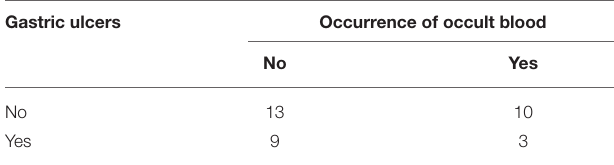
TABLE 7 | Occurrence of occult blood in the feces ( n = 35). Gastric ulcers Occurrence of occult